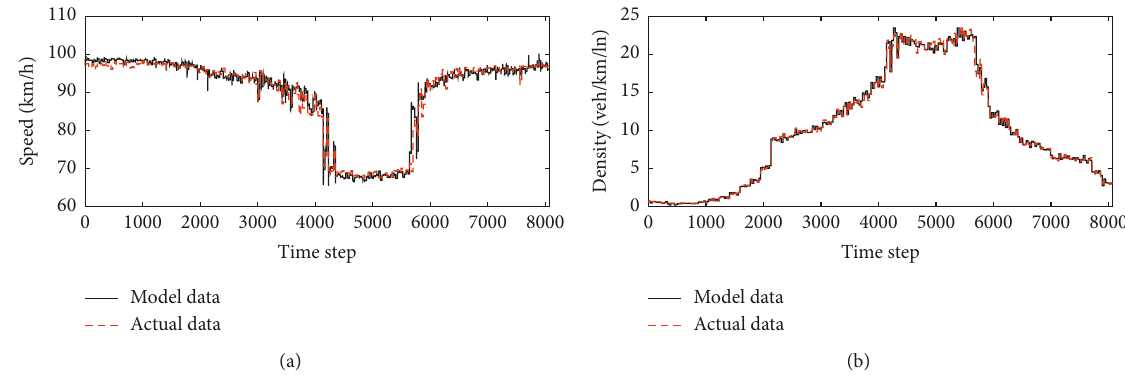
Figure 6: (a) Model speed and actual speed and (b) model density and actual density of case 1.